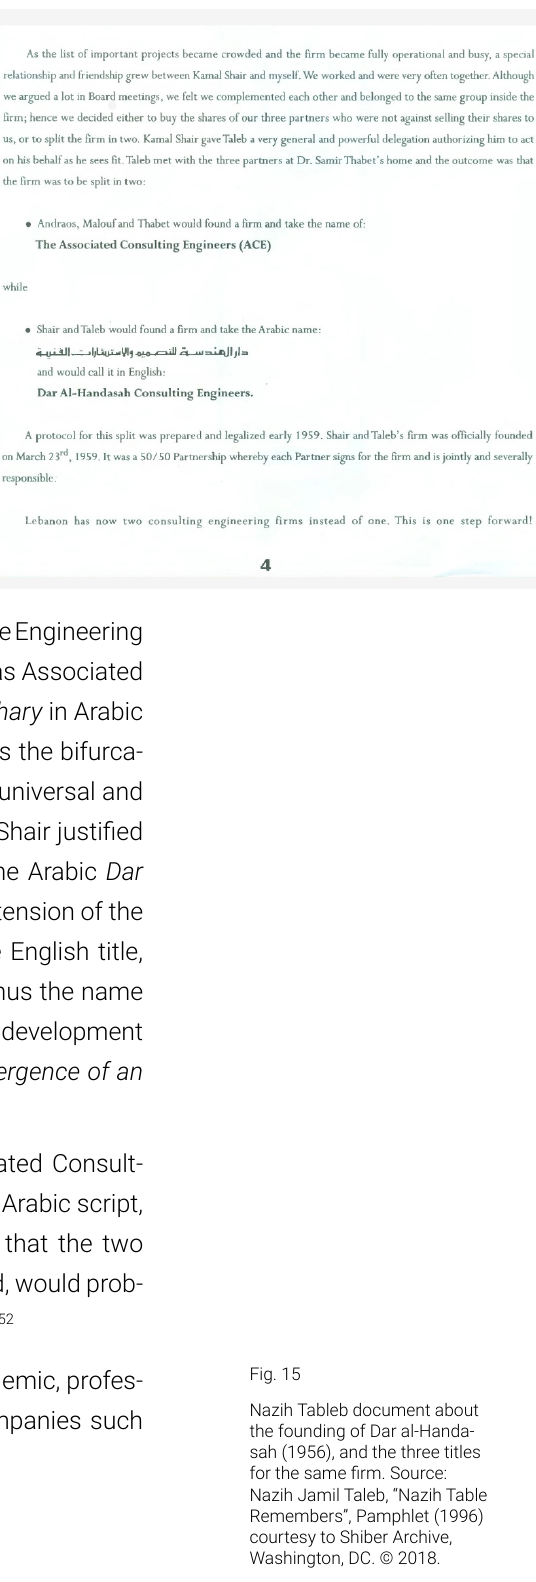
The business split into two firms Dar al-Handasah